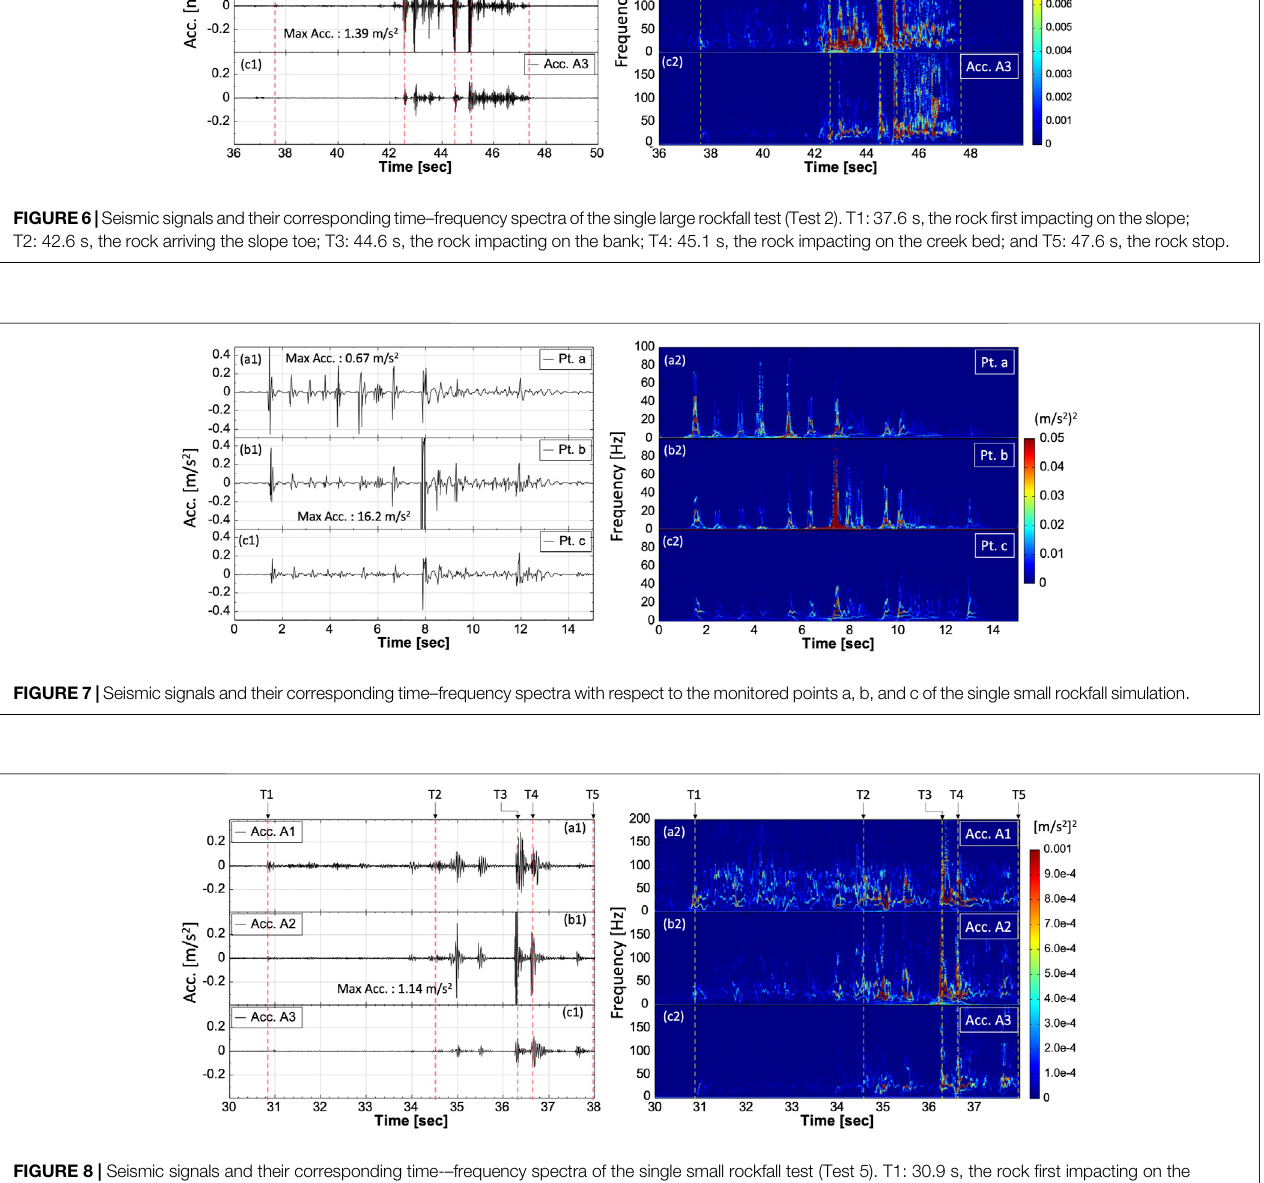
FIGURE 8 | Seismic signals and their corresponding time- – frequency spectra of the single small rockfall test (Test 5). T1: 30.9 s, the rock fi rst impacting on the slope; T2: 34.6 s, the rock arriving at the slope toe; T3: 36.3 s, the rock impacting on the bank; T4: 36.6 s, the rock impacting on the creek bed; and T5: 38.0 s, the rock